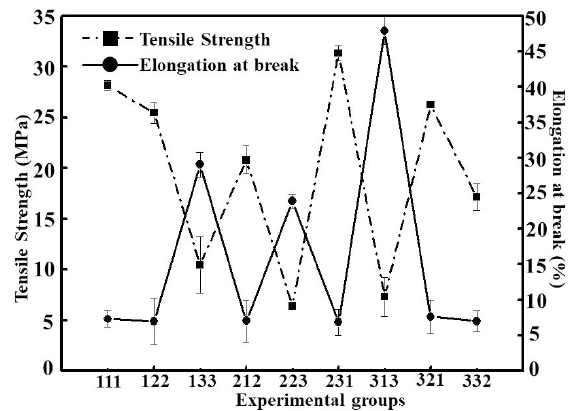
Figure 2. Mechanical properties of different experimental groups ( p < 0.05). Table 2. The structure of the experimental design.